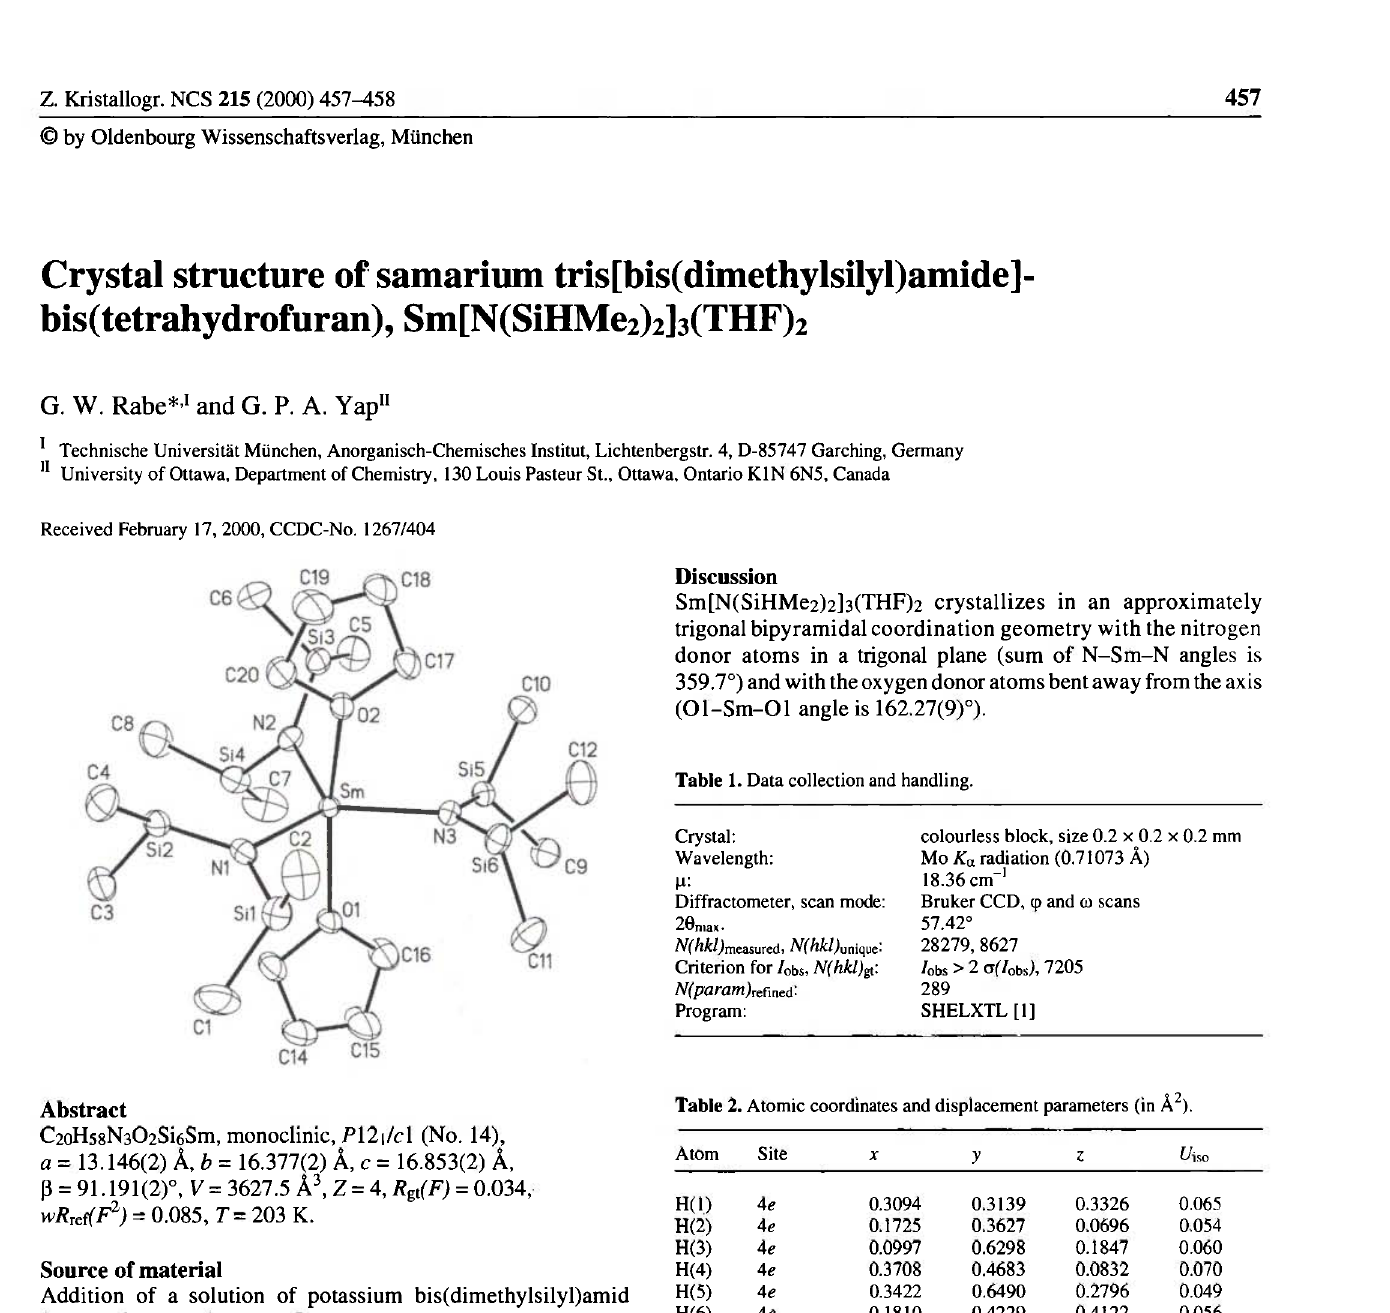
Table 2. Atomic coordinates and displacement parameters (in Ä 2